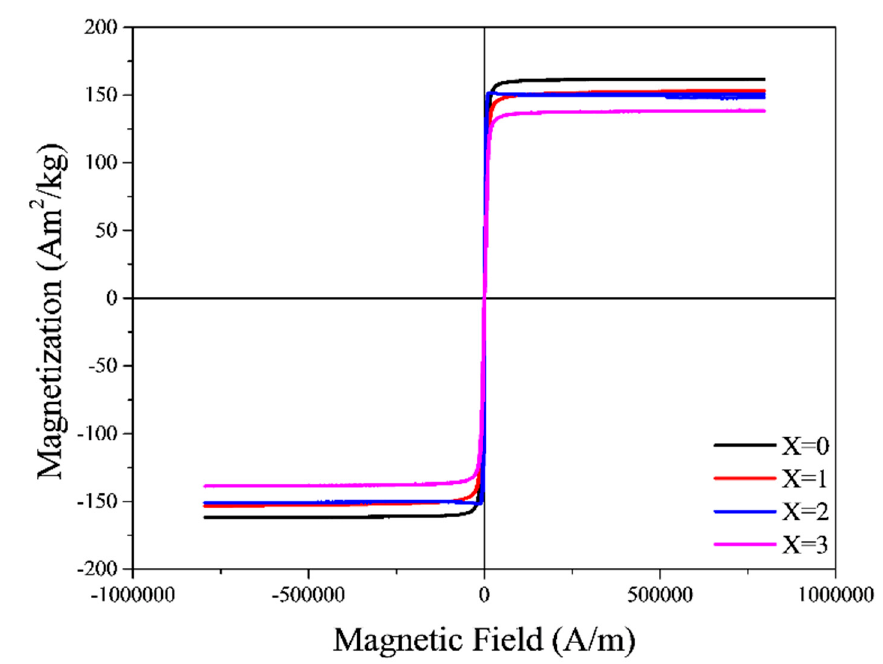
Figure 8. Hysteresis loops for Fe 76 Si 9 − x B 10 P 5 Mo x ( x = 0, 1, 2 and 3) as-spun glassy ribbons.